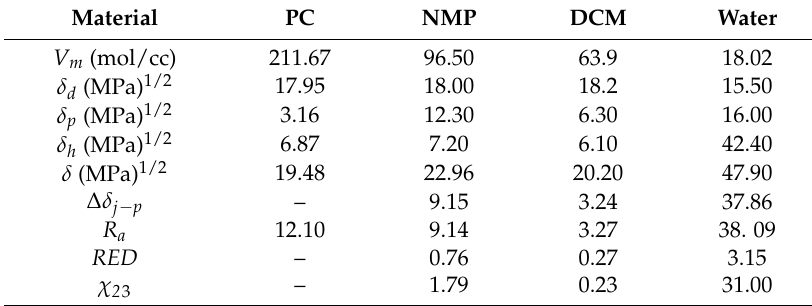
Table 1. Solubility parameter of pure components [27] and calculated solubility parameters difference, Hansen’s solubility parameter distance, RED, and interaction